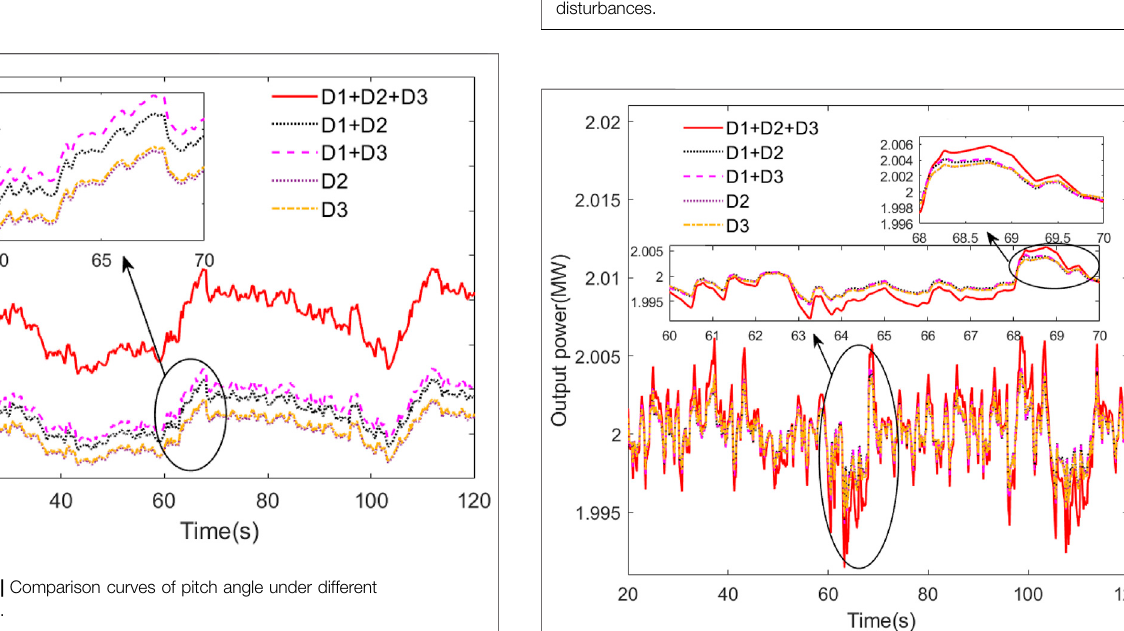
FIGURE 18 | Comparison curves of wind wheel speed under different disturbances.